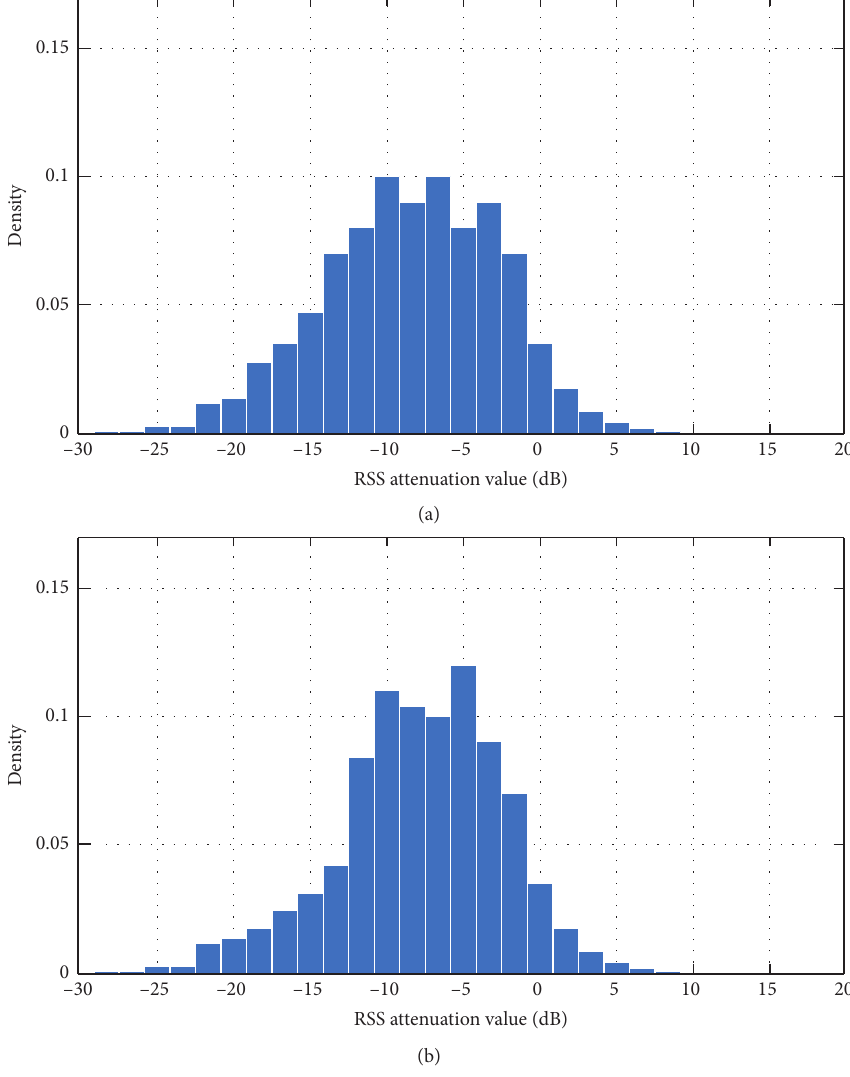
Figure 8: RSS histogram distribution diagram obtained from the single link